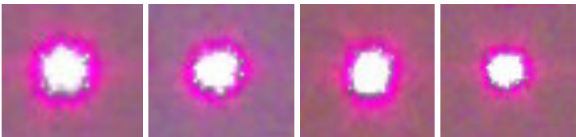
Figure 12. Laser spots from different directions with Mamiya ZD with strong overexposure (white)